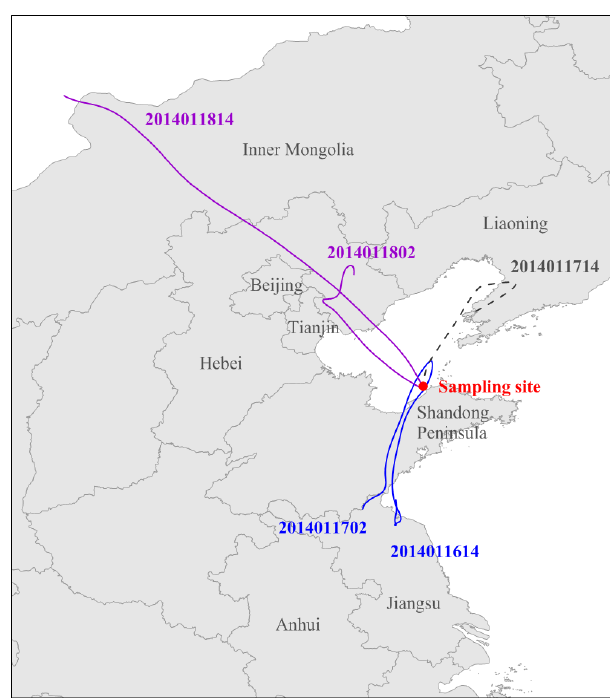
Figure 2. Maps shows 48h back trajectories with 12h intervals of the combined samples (M1 and M2) selected for 14 C analysis.